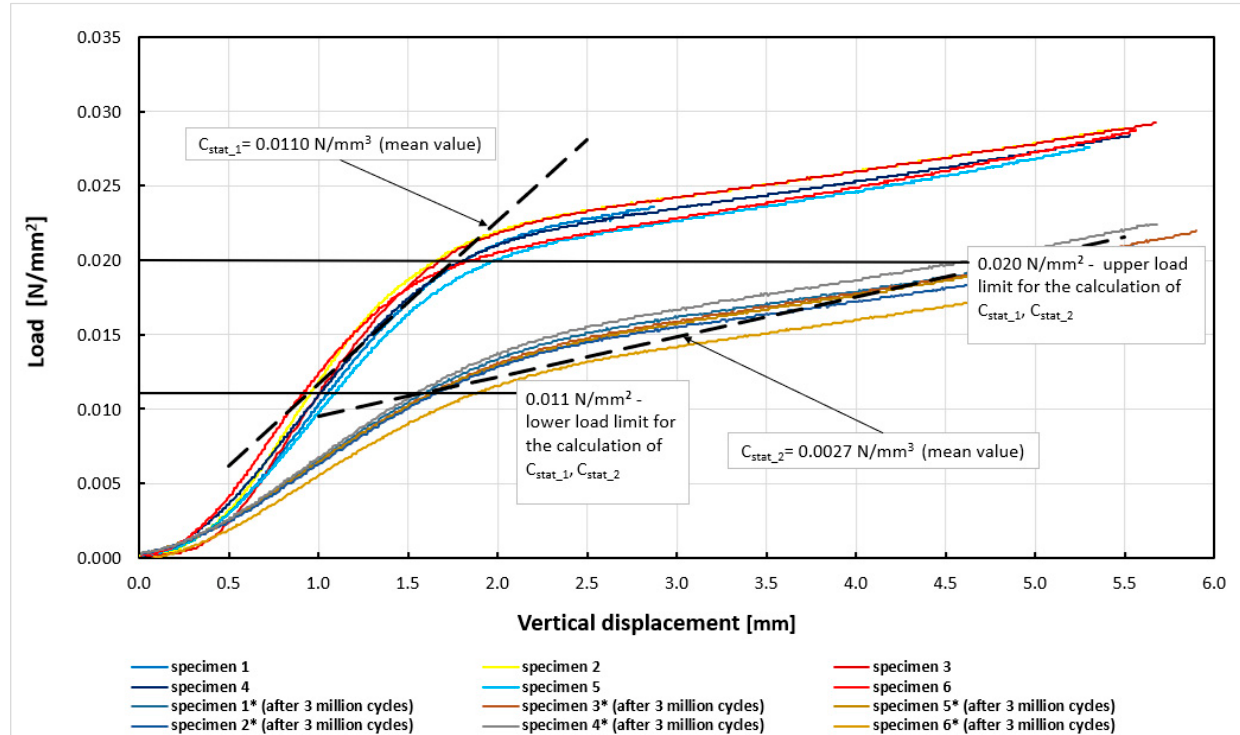
Figure 3. Experimental curves (load vs. displacement) for determining C stat_1 , C stat_2 moduli for Mat A. Table 3. Experimental results of the static bedding modulus C stat for Mat A.